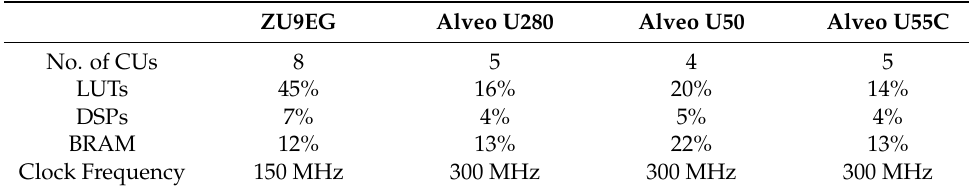
Table 8. Resource utilization (%) and clock frequency per